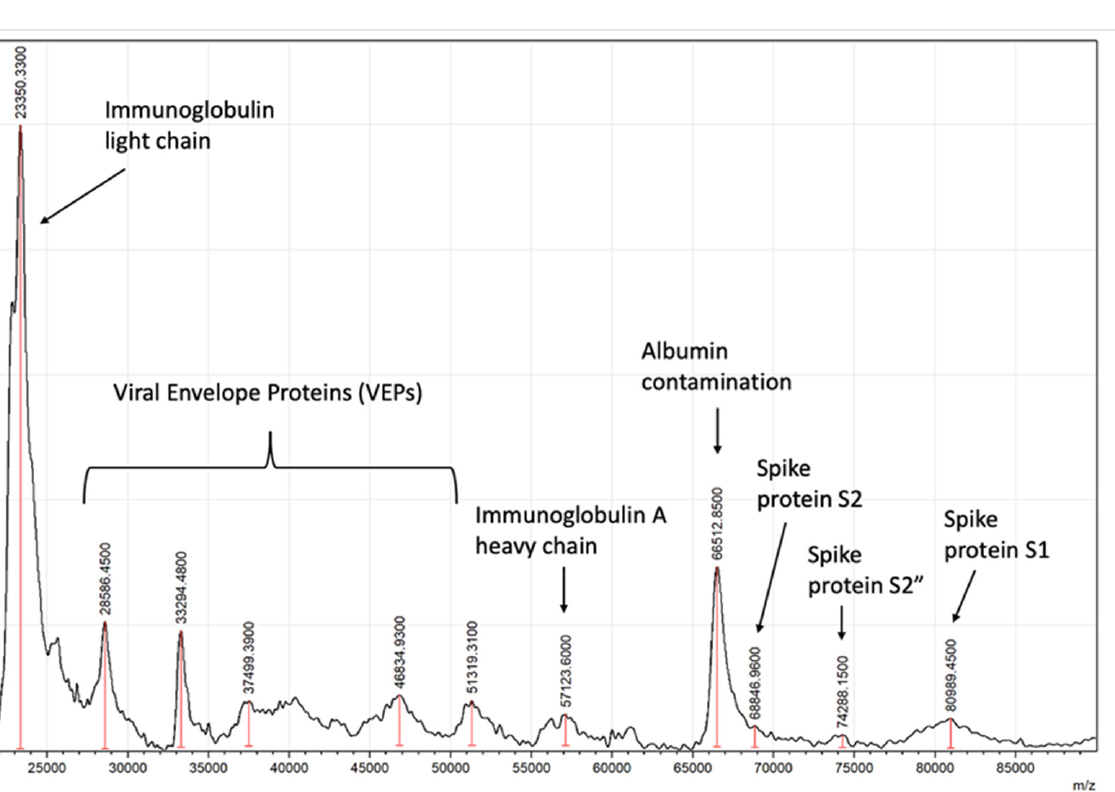
Figure 8. Example of asymptomatic SARS-CoV-2-positive saliva gargle sample mass spectra. 5. CLIA LDT Validation of a MALDI-ToF Mass Spectrometry Test for